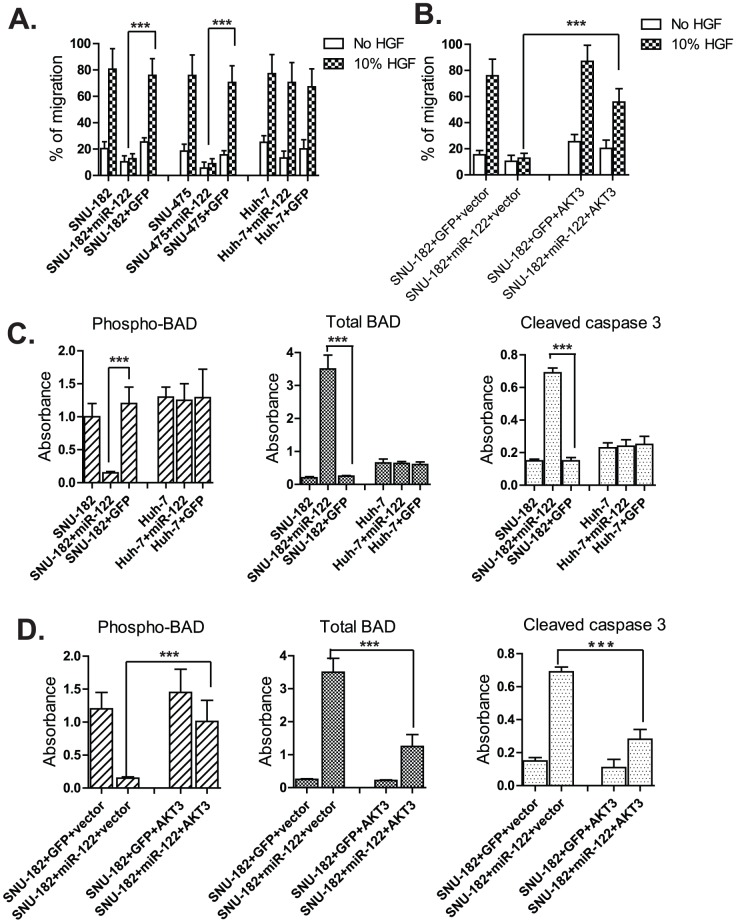
Restoring miR-122 expression in HBV-transformed HCC cell lines inhibited cell migration and induced apoptosis.These miR122 induced anti-tumor activities were rescued by ectopic expression of AKT3. (A) Cell migration assays were performed on SNU-182 or Huh-7 cells over-expressing miR-122 GFP or GFP alone. Migratory responses to the bottom chamber with and without addition of stimulator (10% HGF) are shown. (B) Cell migration assays were performed using miR-122-GFP or GFP alone over-expressing SNU-182 cells with or without AKT3 reconstitution. (C) Phosphorylation of BAD, total BAD level and cleaved caspase 3 were measured in SNU-182 and Huh-7 cells over-expressing miR-122-GFP or GFP alone. (D) Transient reconstitution effects of AKT3 in SNU-182 cells over-expressing miR-122-GFP or GFP alone were also measured. Statistical significance between the indicated groups is depicted as *** P<0.005.